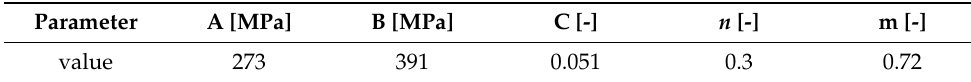
Table 2. Parameters of developed Johnson-Cook constitutive equation.